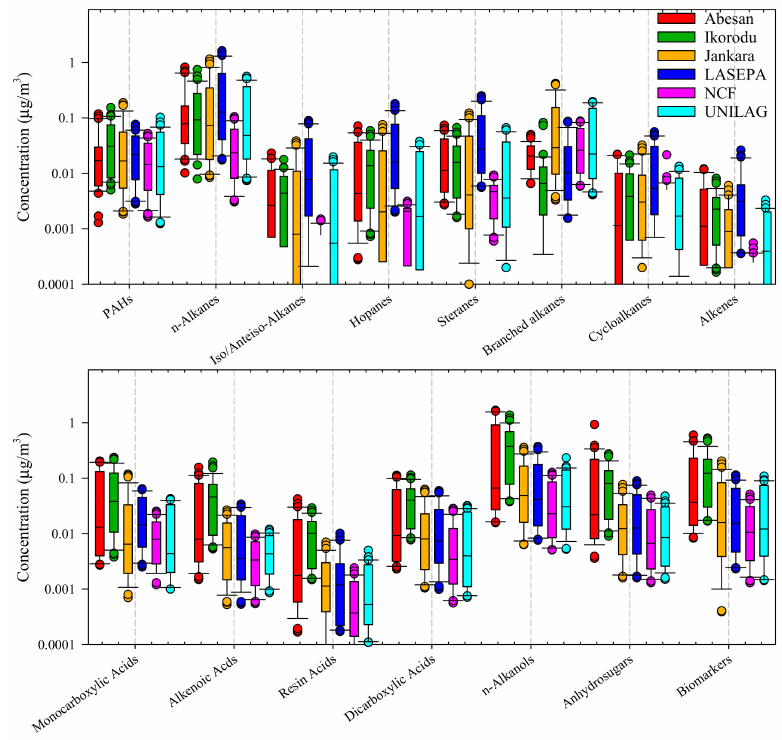
Figure 11. Organic species in PM 2.5 quartz fiber filter samples identified in canister samples by GC-MS. Top panel includes hydrocarbon species. Bottom panel includes oxygenates. OM speciation for PM 10 is included in Figure